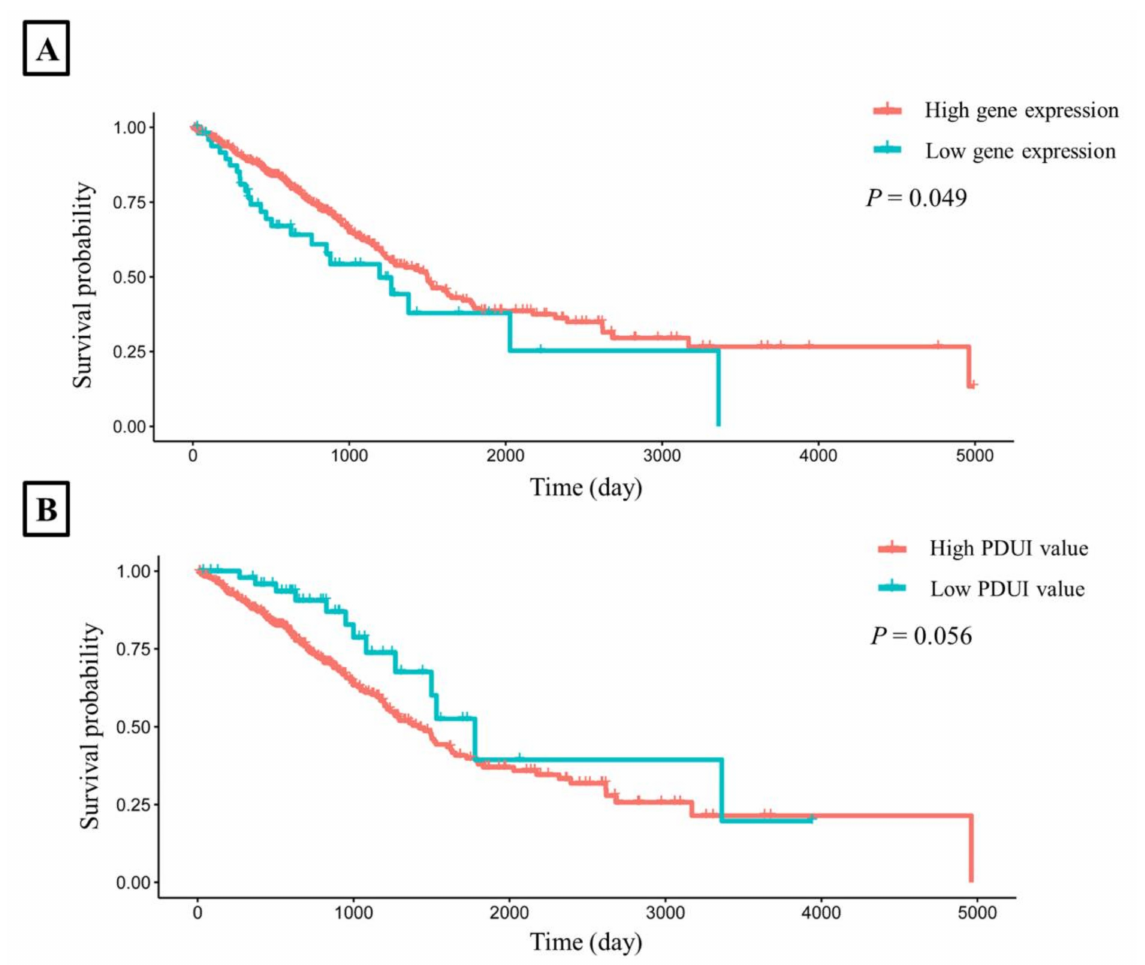
Figure 4. The LUAD survival time curves for CHURC1 . ( A ) Survival analysis of CHURC1 expression. ( B ) Survival analysis of PDUI value of CHURC1 . LUAD, lung adenocarcinoma; PDUI, percentage of distal poly(A) site usage